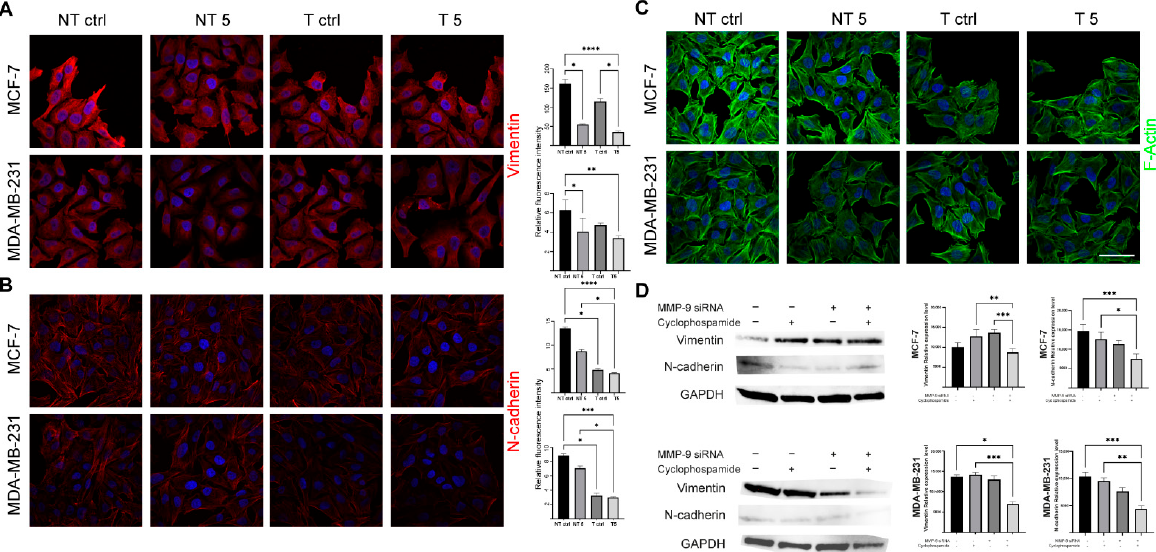
Figure 6. The effect of MMP-9 downregulation on vimentin, N-cadherin and F-actin level. NT—non-transfected cells, T—cells transfected with MMP-9 siRNA, NT5 and T5 non-transfected and transfected cells treated with 5 mM cyclophosphamide for 24 h. ( A ) Immunofluorescent imaging of vimentin (red) and nuclei (blue), and relative fluorescence intensity of vimentin. ( B ) Immunofluorescent imaging of N-cadherin (red) and nuclei (blue), and relative fluorescence intensity of N-cadherin. ( C ), Immunofluorescent imaging of F-actin (green), and nuclei (blue), Bar = 50 µ m. ( D ) The Western blot analysis of vimentin and N-cadherin and densitometric relative expression level of the Western blot experiments. Statistically significant differences were marked with ‘*’ p ≤ 0.05, ‘**’ p ≤ 0.01, ‘***’ p ≤ 0.001, and ‘****’ p ≤ 0.0001 (Kruskal-Wallis test).